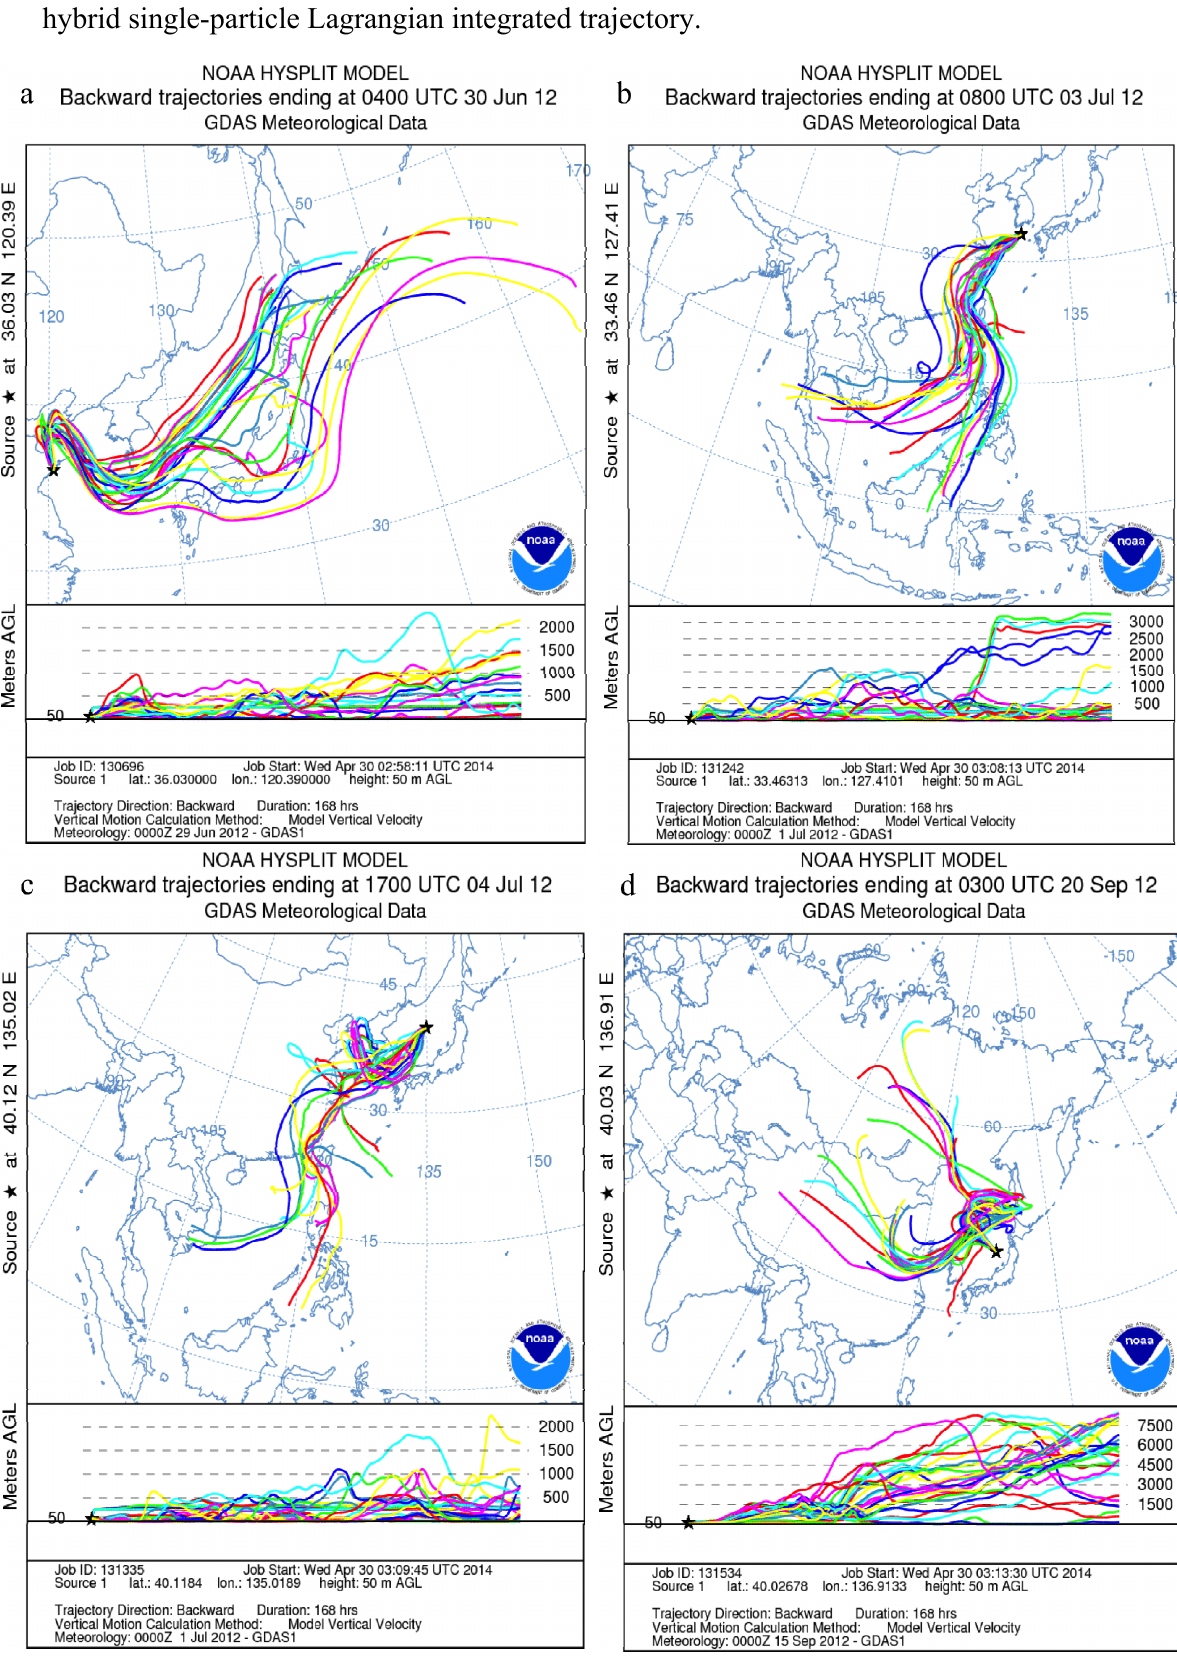
Figure 4. Seven-day air mass backward trajectories of some special locations belonging to offshore China and the Sea of Japan. ( a , b , c ) Departing route; ( d , e , f ) return route. HYSPLIT, hybrid single-particle Lagrangian integrated